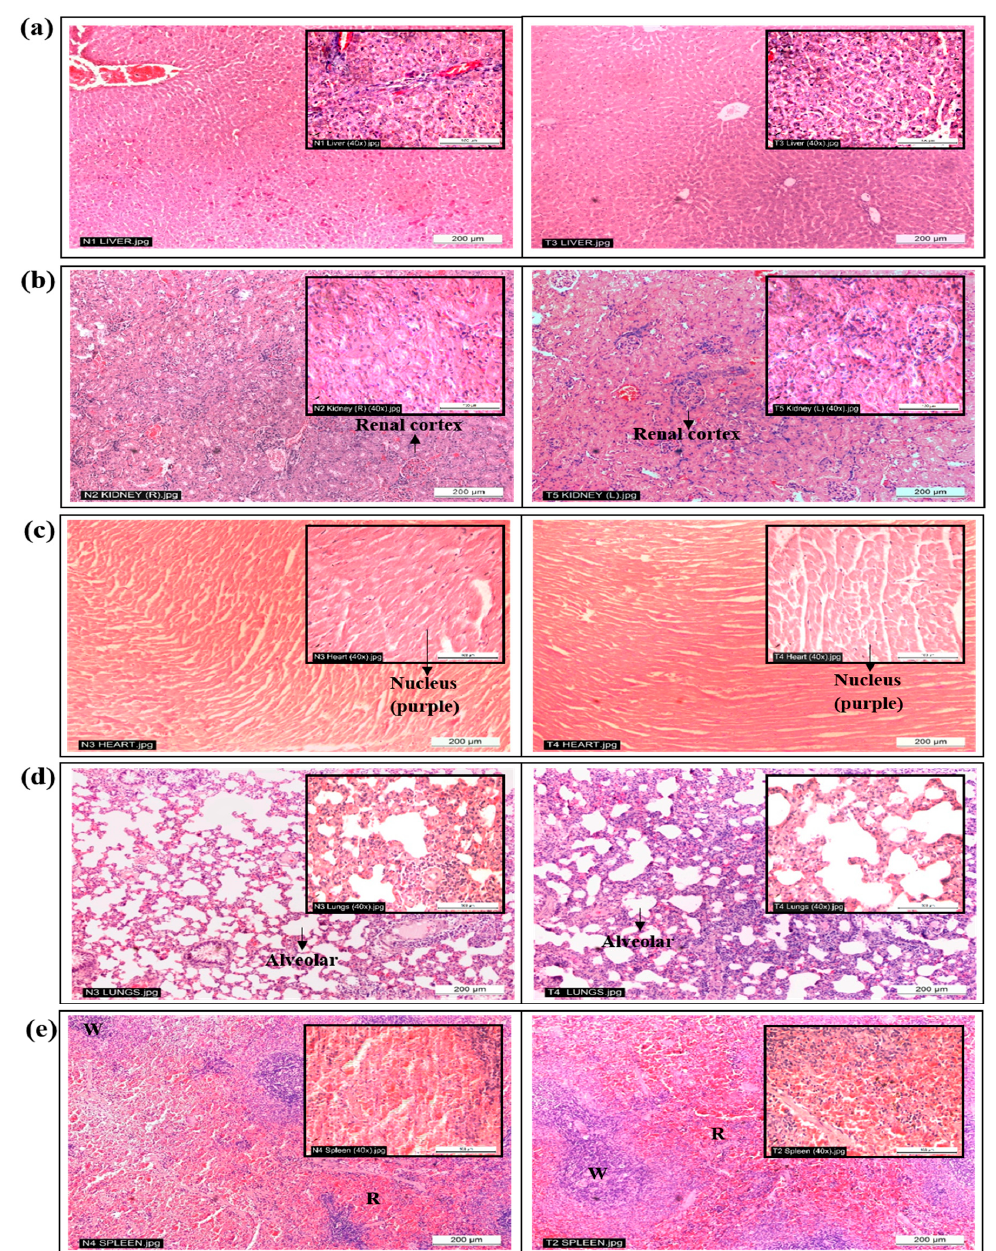
Figure 2. Representative photographs of histological sections of ( a ) liver, ( b ) kidney, ( c ) heart, ( d ) lung and ( e ) spleen tissues of rats given distilled water ( left ) and 5000 mg/kg of Clinacanthus nutans water leaf extract ( right ) showing normal architectures (H & E ×100 magnification; Inset: ×400 magnification). White pulp (W); Red pulp (R). leaf extract ( right ) showing normal architectures (H & E × 100 magnification; Inset: × 400 magnification). White pulp (W); Red pulp